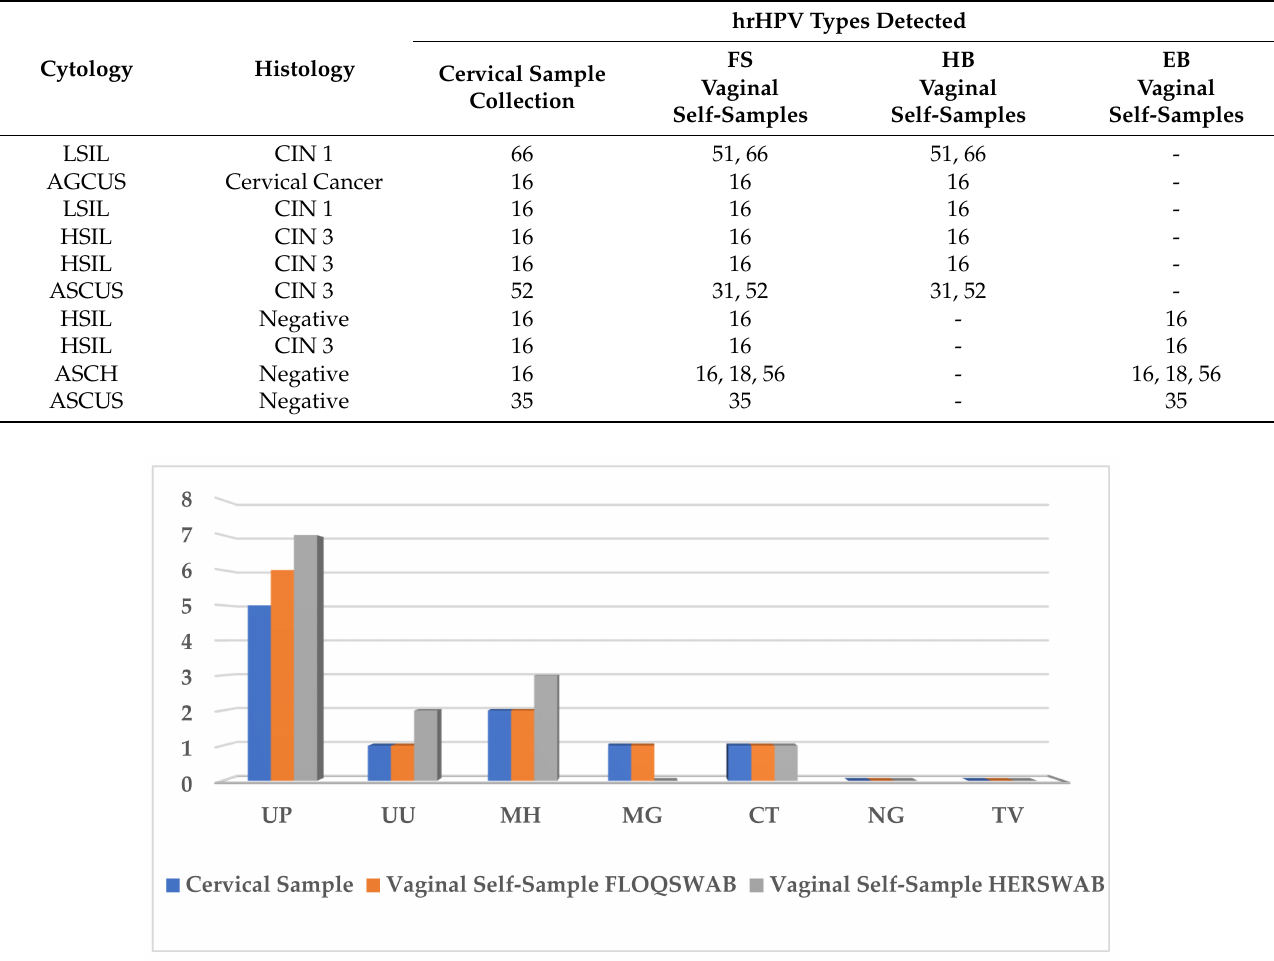
Figure 4. Prevalence of STI pathogens in cervical samples and vaginal self-samples collected using FLOQSwabs ® (FS) and HerSwab™ (HS). Seven STI pathogens were detected: Chlamydia